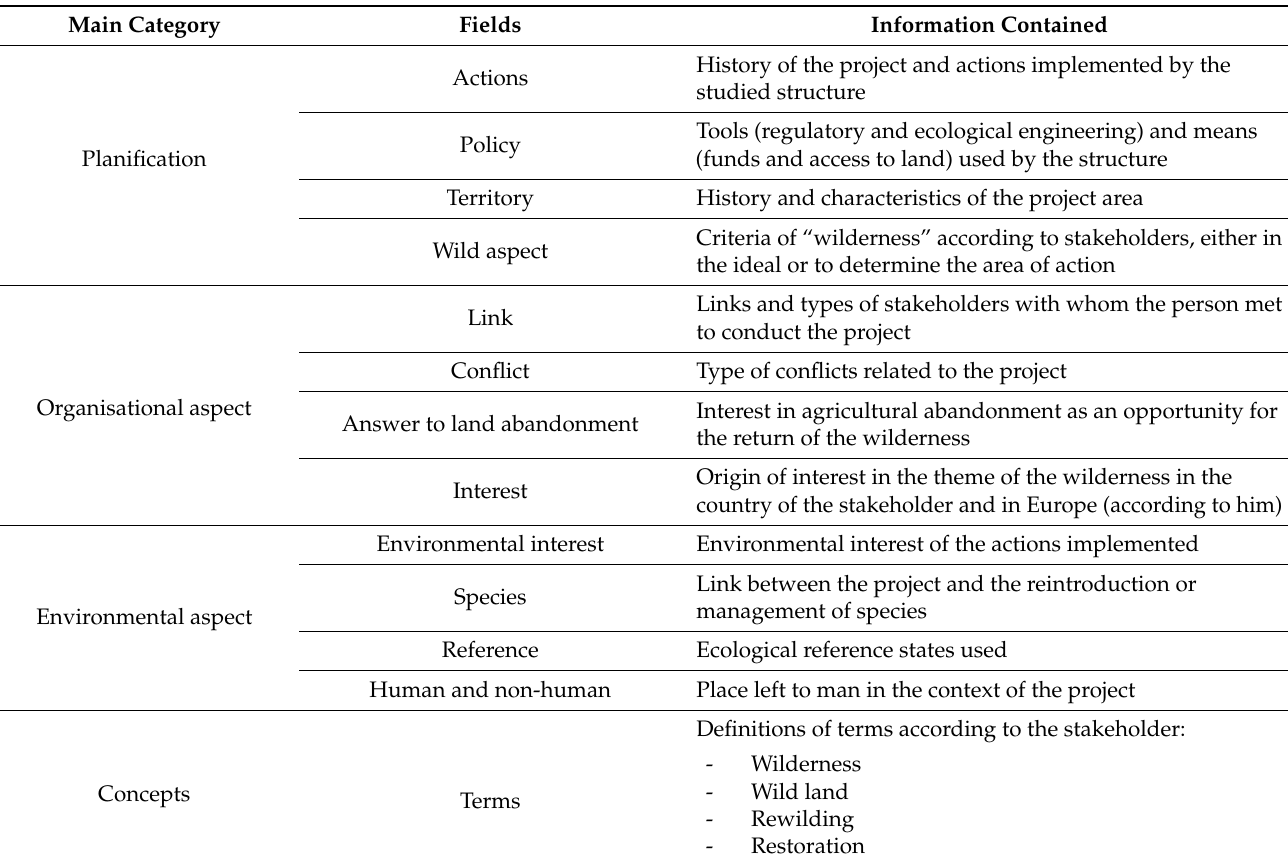
Table 2. Metadata and categories of the database “Interview” (adapted from Locquet [5]).